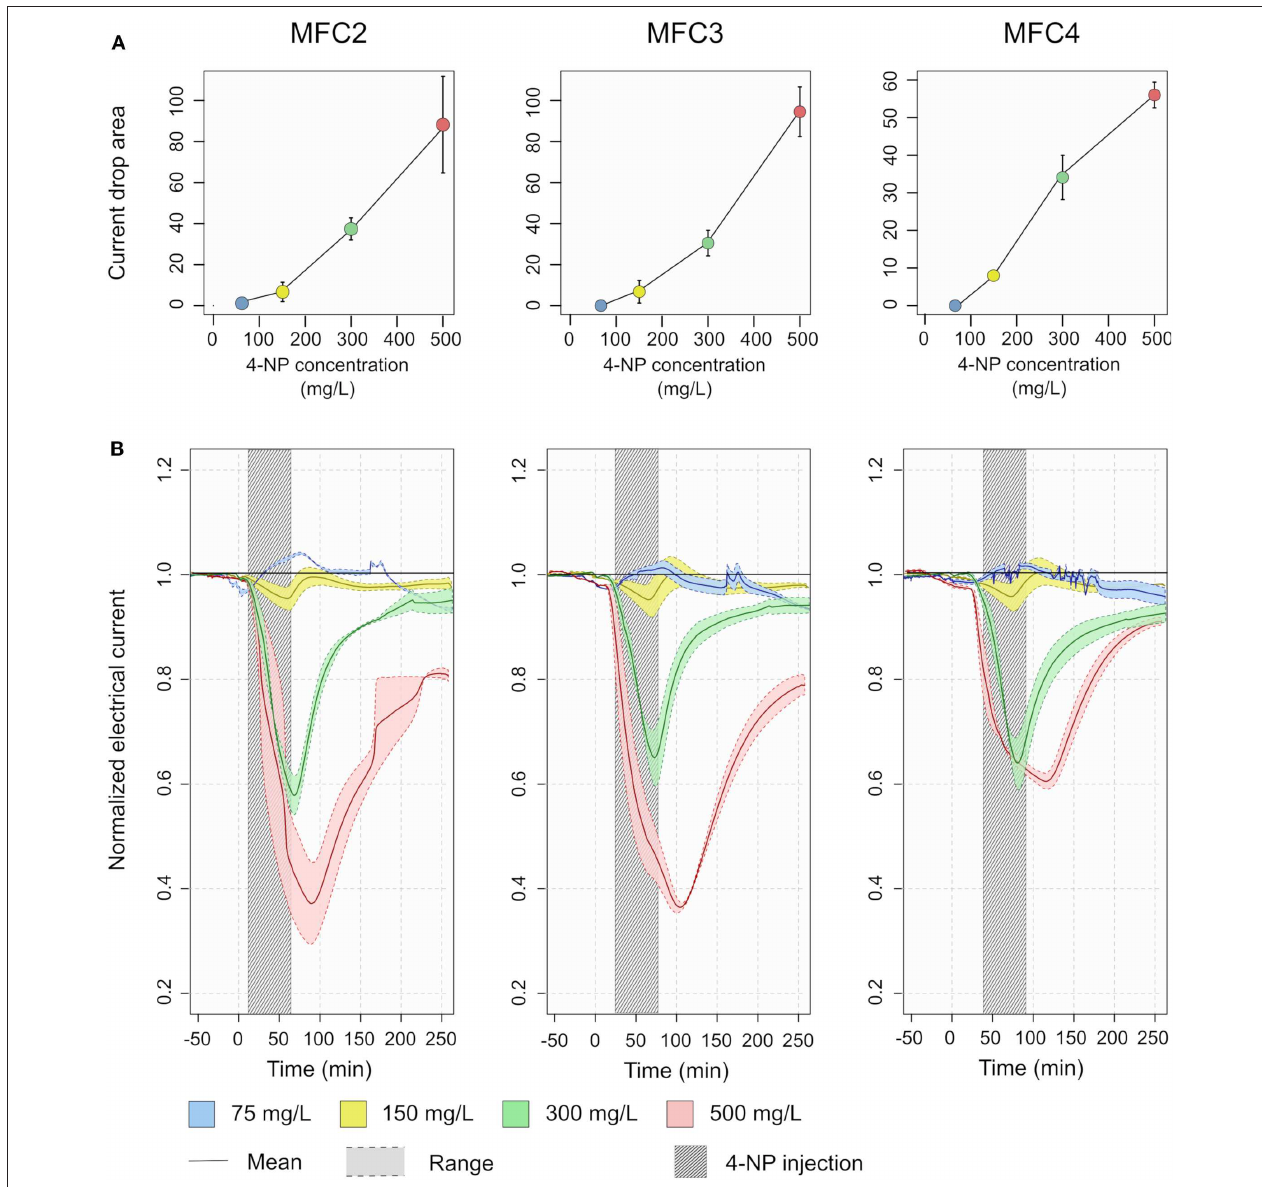
FIGURE 4 | Toxicity detection in MFC2, 3 and 4. (A) The current drop area, measured as normalized current (Inorm) between –50 and 250 min were calculated for each acute toxicity test. (B) The normalized electrical current measured as a function of time during acute toxicity tests for different concentrations of 4-NP. The lines represent the mean of the reactors and the shadded area around the colored lines represent the range. The dark gray shaded rectangle represents the period where the 4-NP was present in the influent medium.